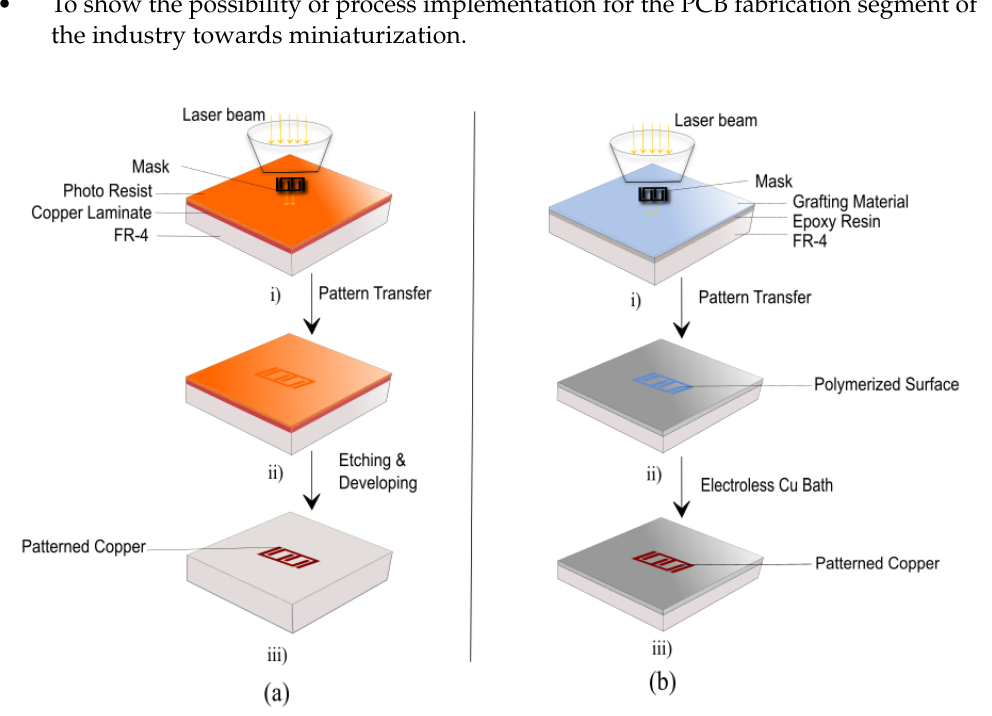
Figure 1. Main patterning and metallization steps in the PCB fabrication: ( a ) A conventional Sub- tractive etch-and-print Technology. ( b ) A fully additive technology named SBU-CBM approach with selective